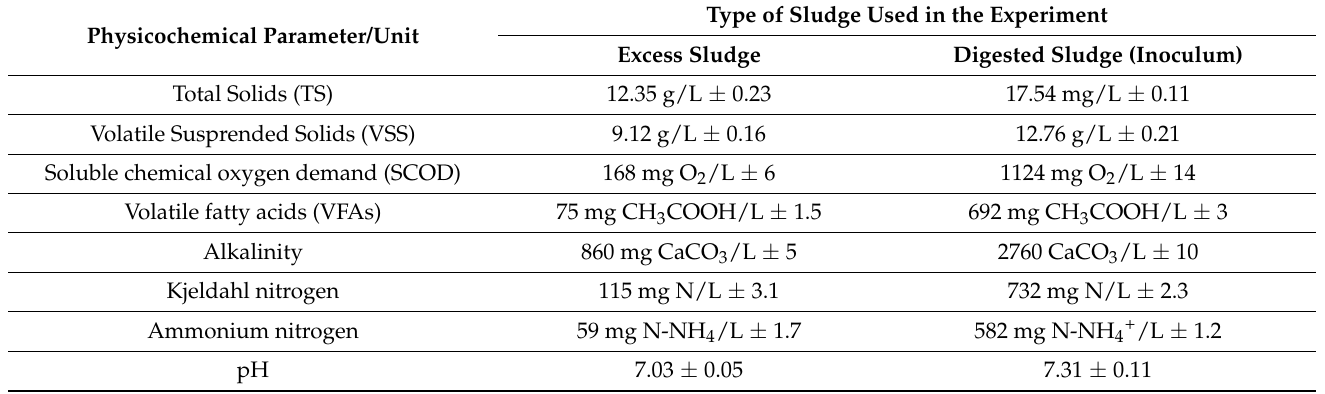
Table 1. Characterization of the substrates in the